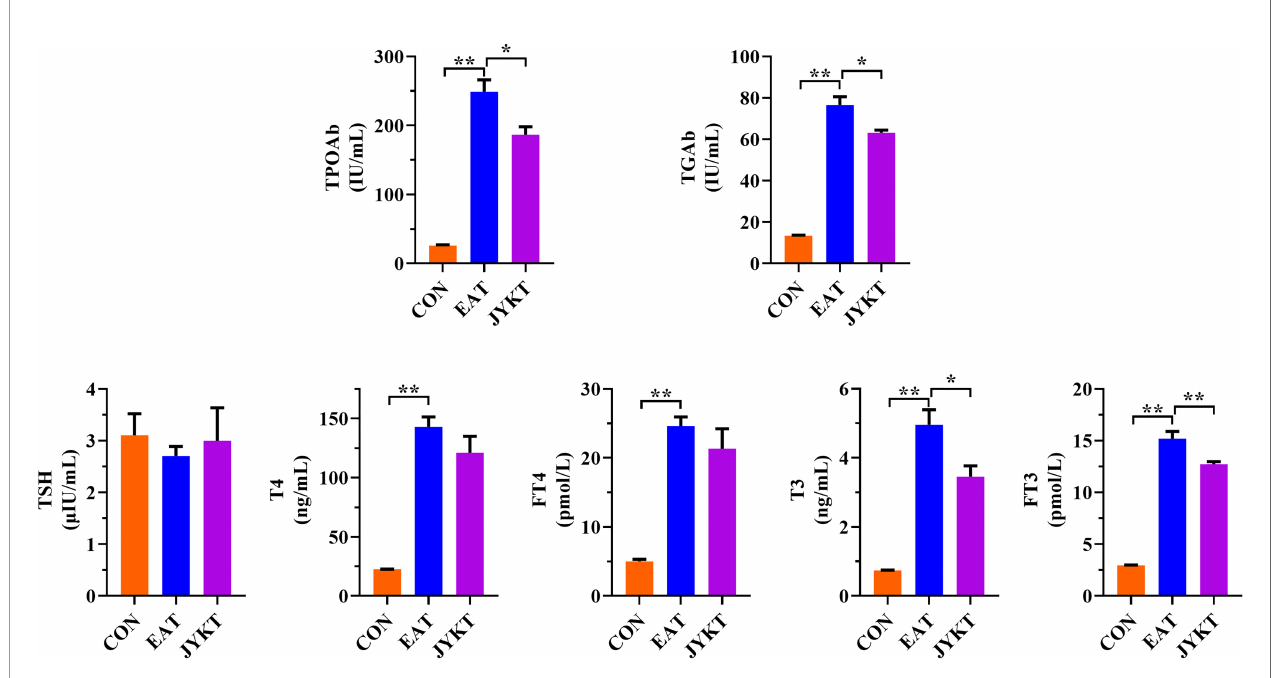
FIGURE 4 | Serum levels of thyroid autoantibodies and hormones. ** P < 0. 01, *P < 0.